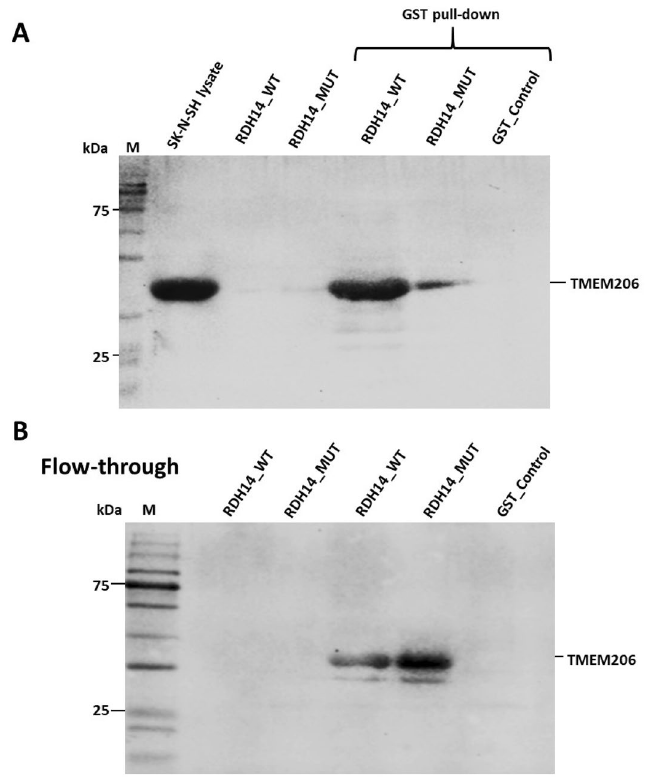
Figure 3. Western blotting showing GST pull-down of TMEM206/PACC1 from SK-N-SH cell lysate using wild-type (WT) versus mutant RDH14-GST constructs. A TMEM206 (PACC1) rabbit polyclonal antibody (1:1000 dilution; catalogue #TA342366; Origene Technologies, Rockville, MD) was used. ( A ) Input to lane 1 was SK-N-SH cell lysate (as a positive control). Lanes 2 and 3 show extracted protein for the RDH14-GST constructs, WT and mutant, respectively (as negative controls). In lanes 4, 5, and 6, the GST pull-down eluted protein, for WT and mutant RDH14-GST, and GST alone (as negative control), respectively (i.e. bait protein against prey input). ( B ) Flow-through from lanes 2–6 above was run and probed with the TMEM206 antibody. Western hybridization using GST antibodies was also performed to check sample loading (Supplementary Fig.